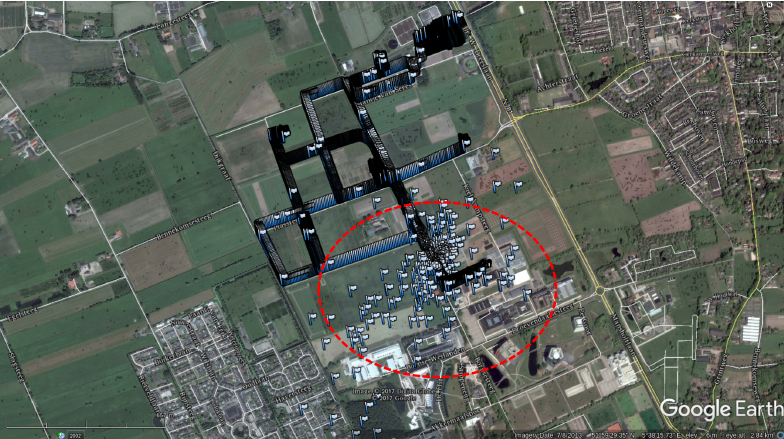
Figure 10. Trajectory obtained with WARTK for the spraying tractor TPSD during the whole agriculture activity (from 06 h 11 m to 13 h, day 164, 2017).